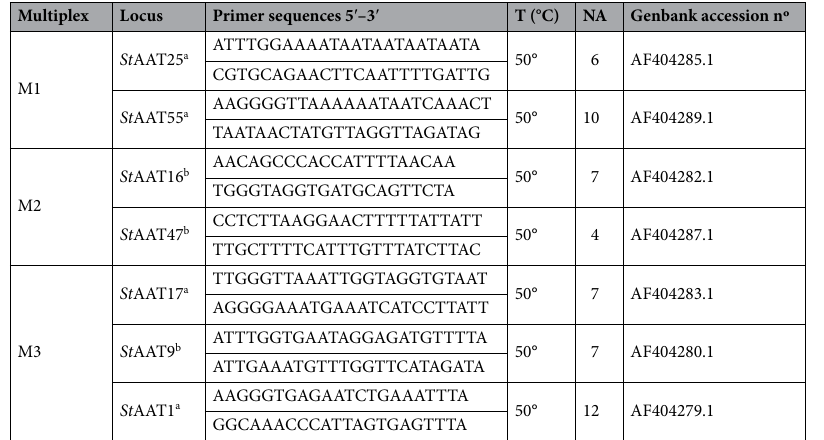
Table 2. Polymorphic markers used to genotype native populations of S. terebinthifolia . Microsatellite loci, primer sequences (5 ′ –3 ′ ), annealing temperature (°C), number of alleles (NA) and accession